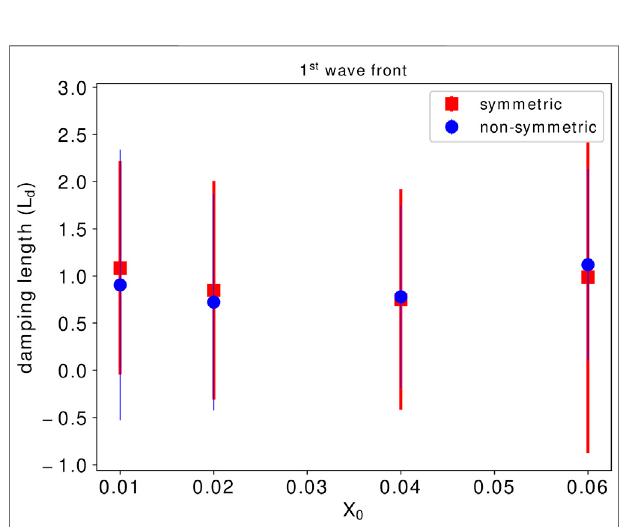
FIGURE 5 | The graph shows the power amplitude of the fundamental wavemodeasafunctionofthe z axis.Theorangecurveistheparabolic fi t,and the green dots are the approximate peak values of the wave at speci fi c times. Blue dots represent the errors of the numpypolyfit